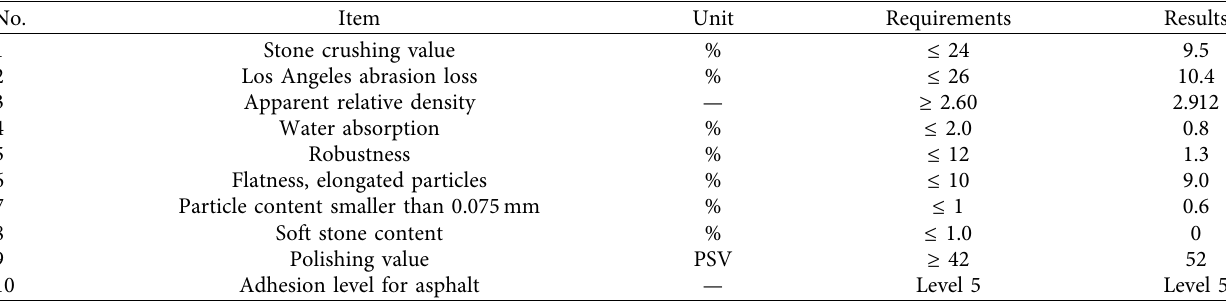
Table 2: Technical properties of hard sandstone aggregate.